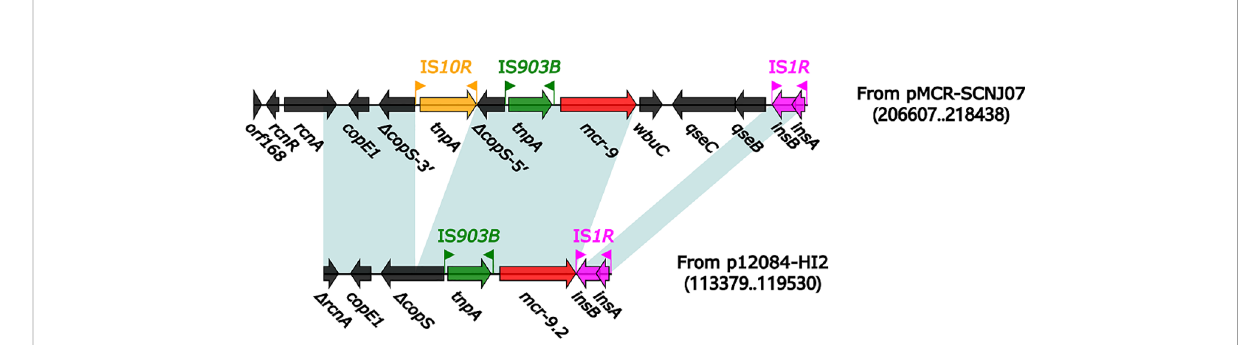
FIGURE 3 Organization of the mcr genetic environment from p12084-HI2 compared with related reference regions. Genes are denoted by arrows. Genes, mobile elements, and other features are colored based on function classi fi cation. Shading denotes regions of homology (>95% nucleotide identity). Numbers in parentheses indicate the nucleotide positions within the corresponding plasmids. The accession number of the pMCR- SCNJ07 is